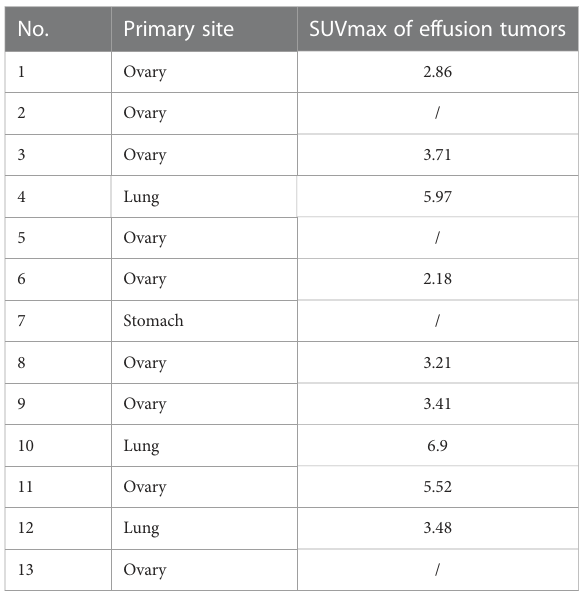
TABLE 3 18 F-FDG uptake of effusion tumors.